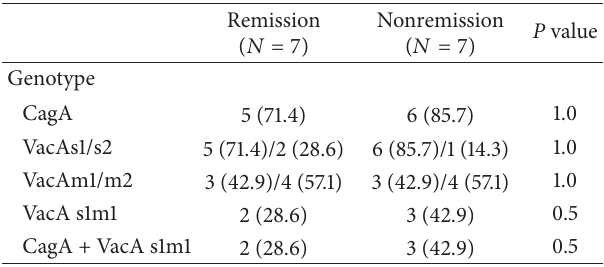
Table 2: The expression of virulence factors for CSU patients in remission and nonremission status after successful H. pylori eradication